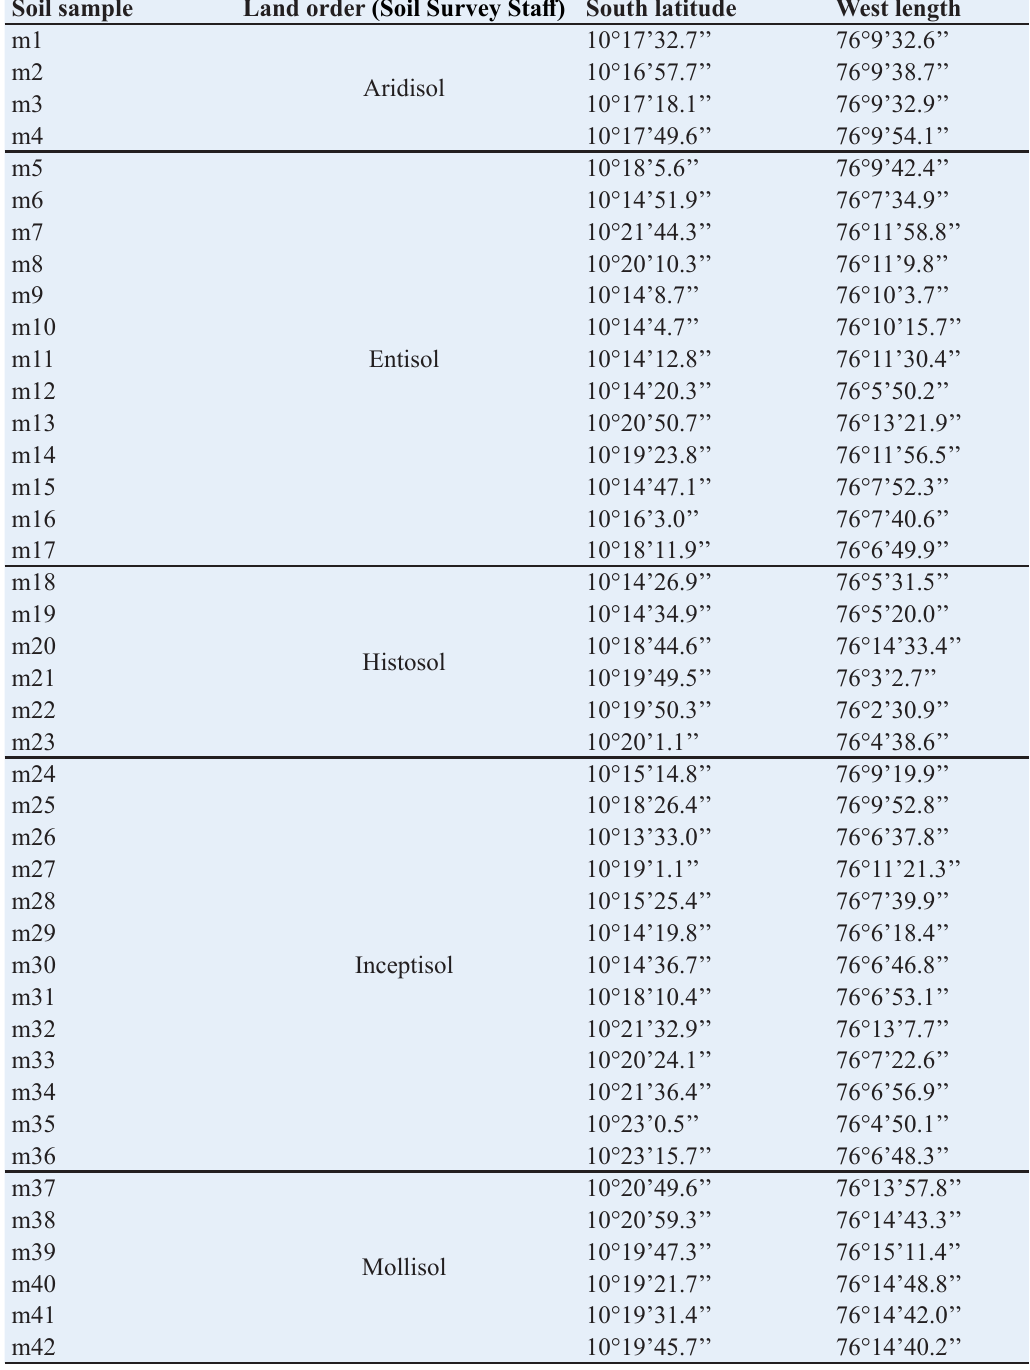
Table 1: Location of the sampled